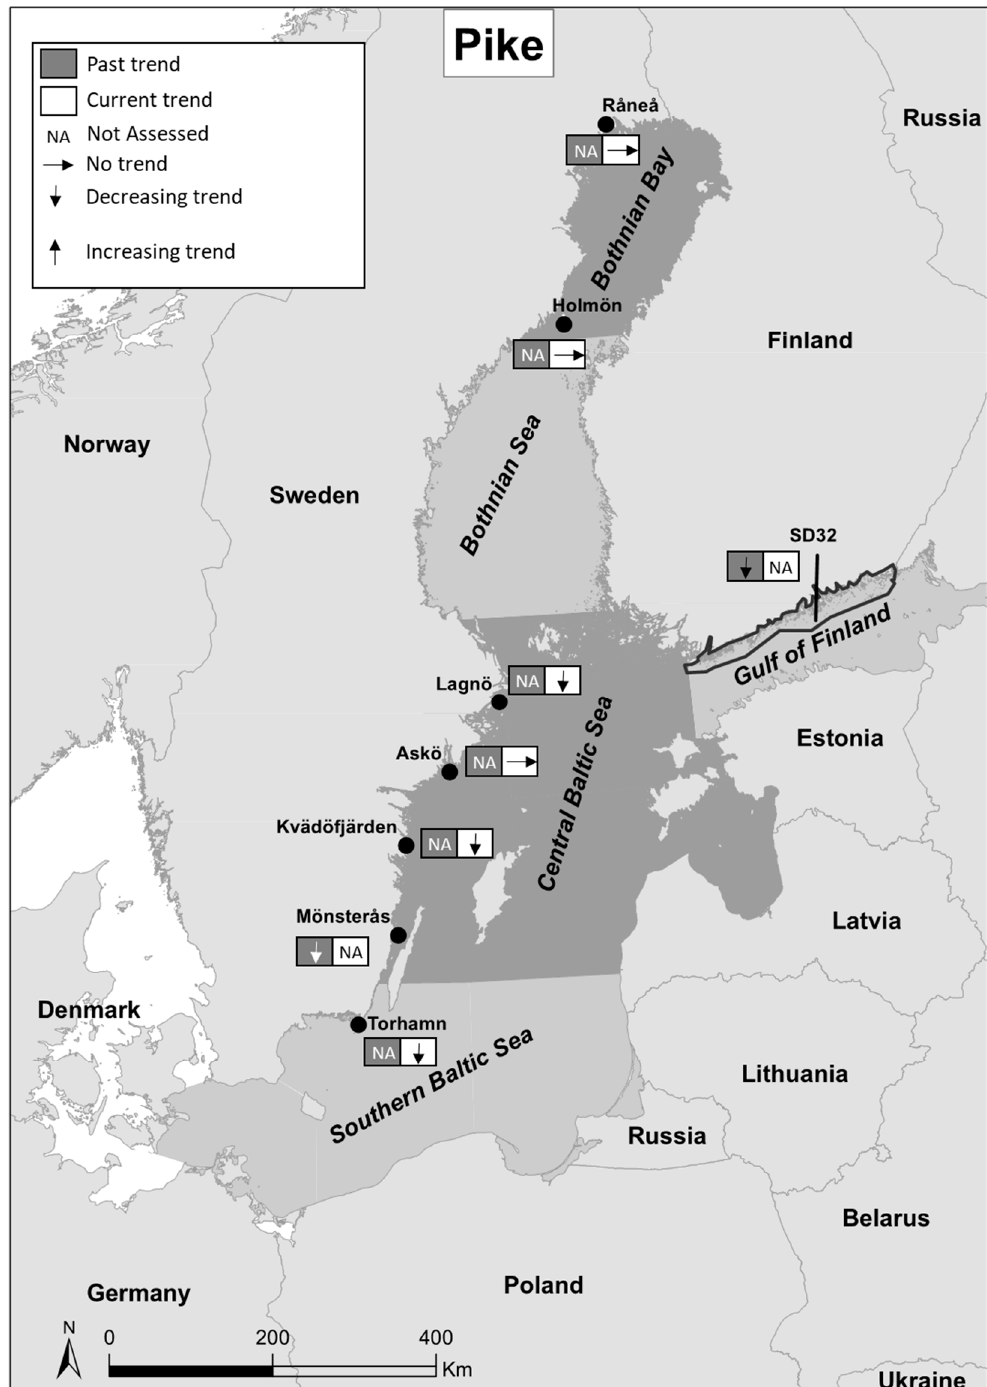
Figure 4. Overview of the trends in abundance of pike for the few areas in the Baltic Sea for which information (publications and national status assessments) are available. An up-ward pointing arrow denote increasing trends in abundance, a horizontal arrow no trend in abundance, and a down-ward pointing arrow a decreasing abundance. NA denotes that no assessment/data is available. For each area, past trends are shown in a grey box and current trends in a white box. Time-period considered in each area and box are outlined in the main text and in Table 3.